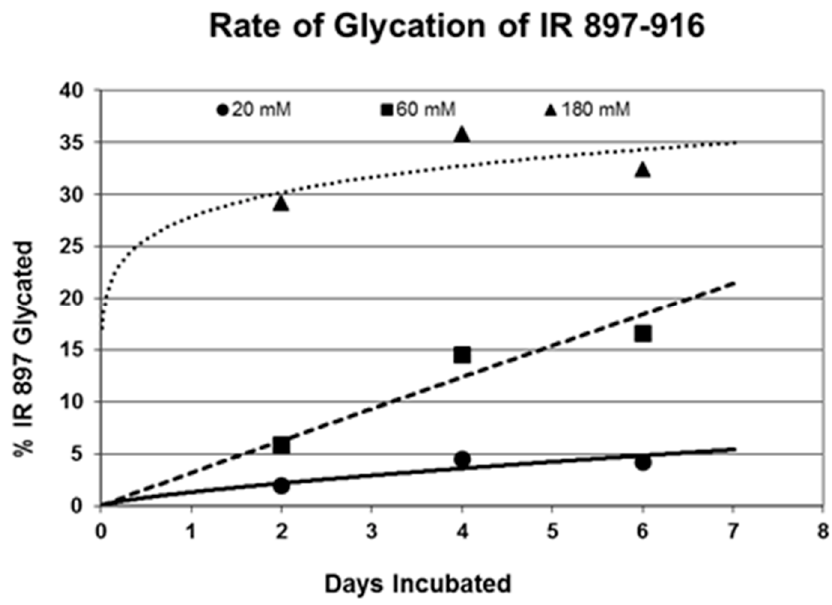
Figure 6. Rate of glycation of IR 897–916 at various concentrations of glucose as determined by MALDI-TOF.